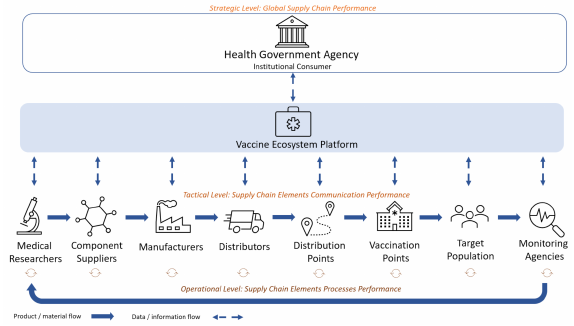
Figure 4. Vaccine ecosystem: stakeholders’